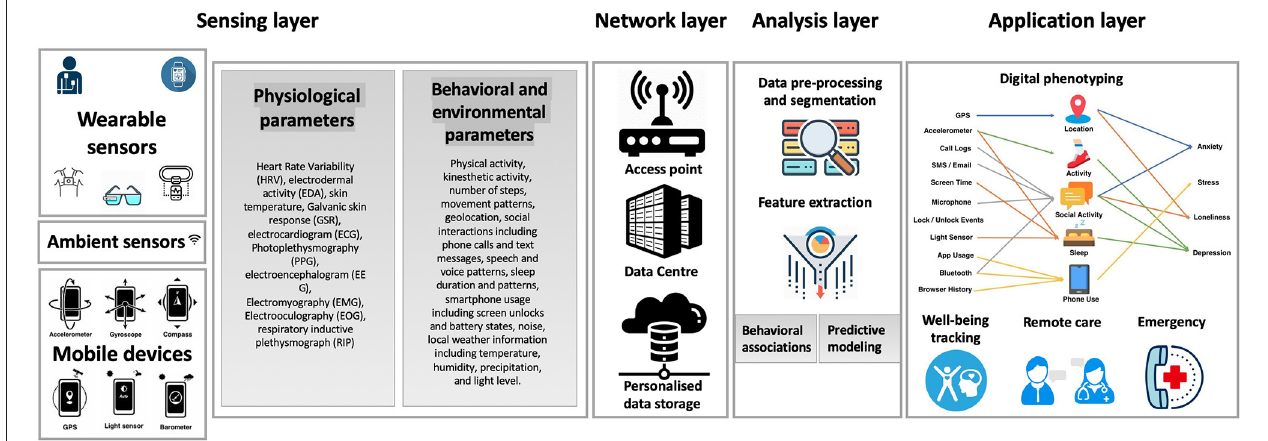
FIGURE 4 | Overview of the workflow of mental health monitoring